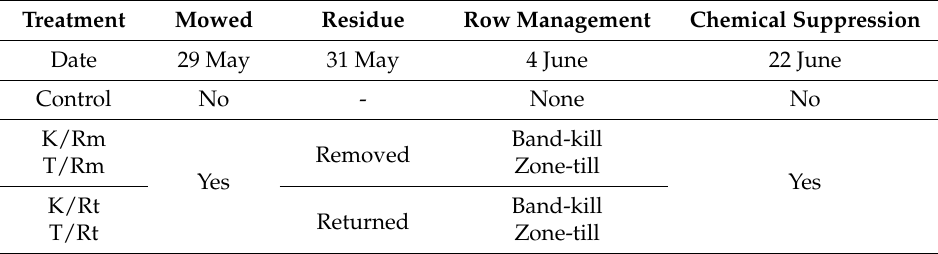
Table 1. Chronological clover suppression management by management